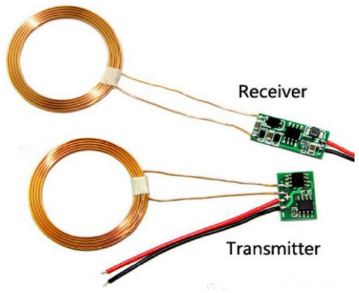
Figure 5. XKT-510 IC based wireless charging